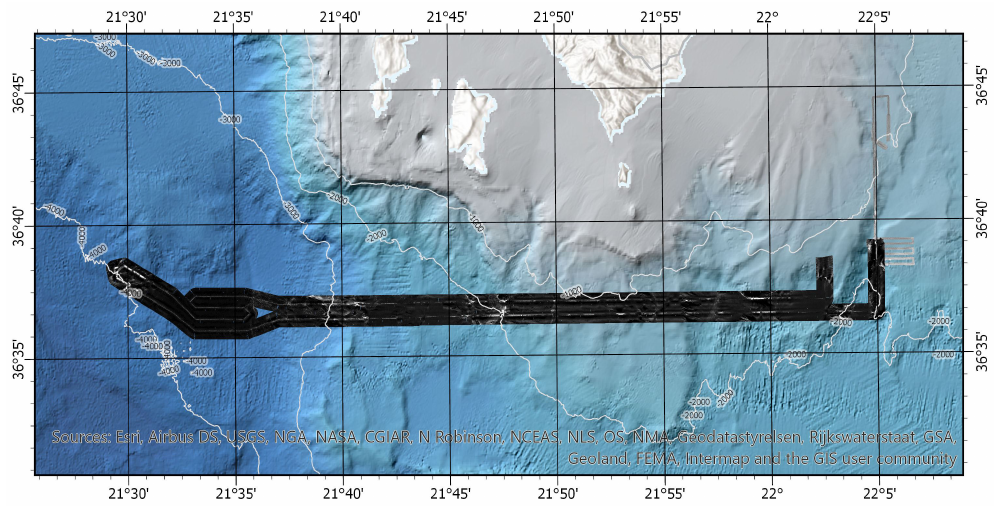
Figure 9. The results of survey: backscatter, combined from all AUV’s sensors, 1 m